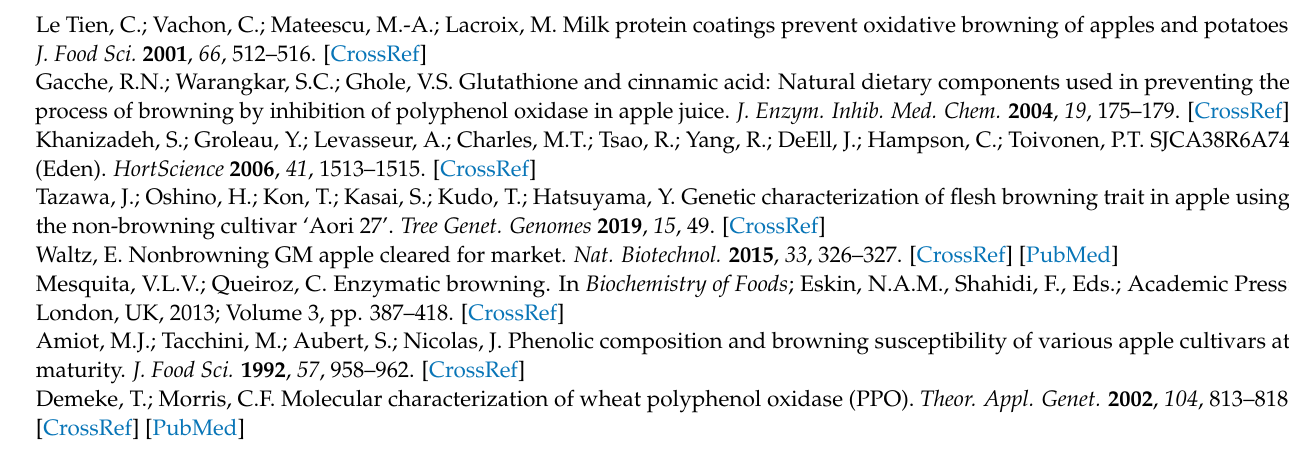
Table S8: HSD test for phenolic groups, hydroxycinnamic acids, dihydrochalcones, flavonols and flavan-3-ols in apple flesh, peel and leaves with estimated ratios of averages and corresponding 95% confidence intervals (lwr, lower boundary; upr, upper boundary), for time (harvest, storage), location (L1 and L2), and cultivar (GD, ‘Golden Delicious’; MA, ‘Majda’). Table S9: The contrast analysis for PPO and POX with estimated ratios of averages and corresponding 95% confidence intervals (lwr, lower boundary; upr, upper boundary), for time (harvest, storage), location (L1 and L2), and cultivar (GD, ‘Golden Delicious’; MA, ‘Majda’). Table S10: Meteorological conditions during the vegetation period (1. 4. 2019–30. 9. 2021) on locations L1 and